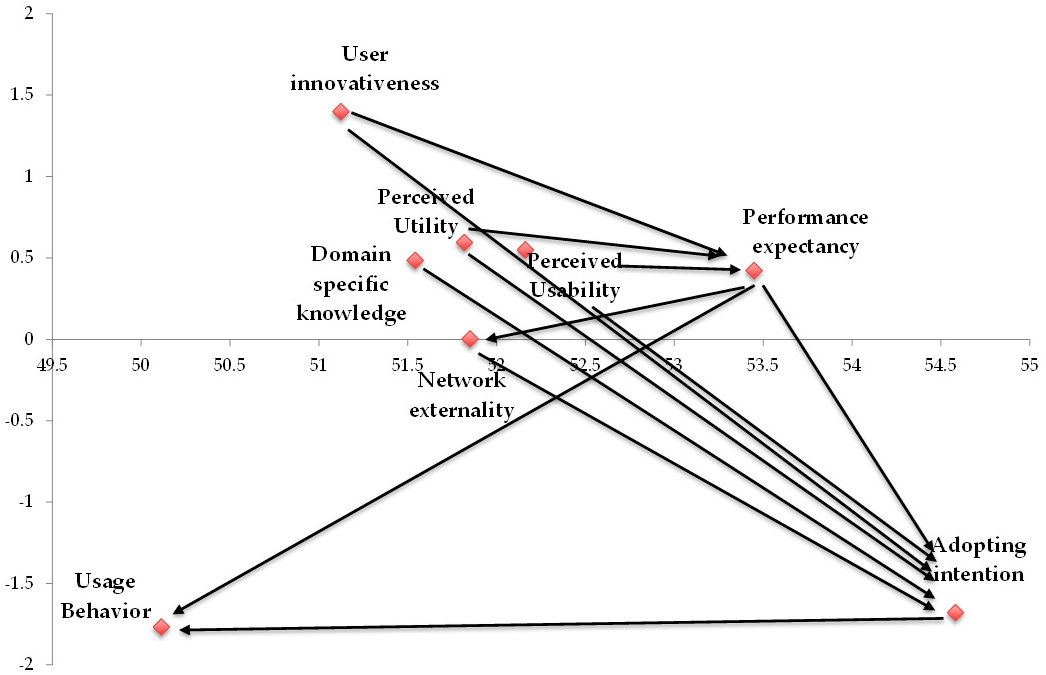
Figure 2. The influential causal relationship by DEMATEL method.